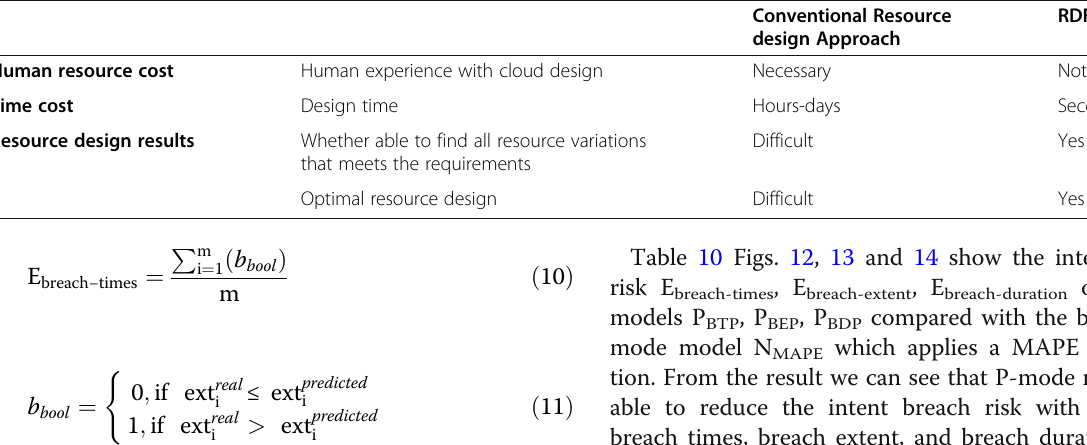
Table 9 Effect of RDF compared to conventional resource design approach